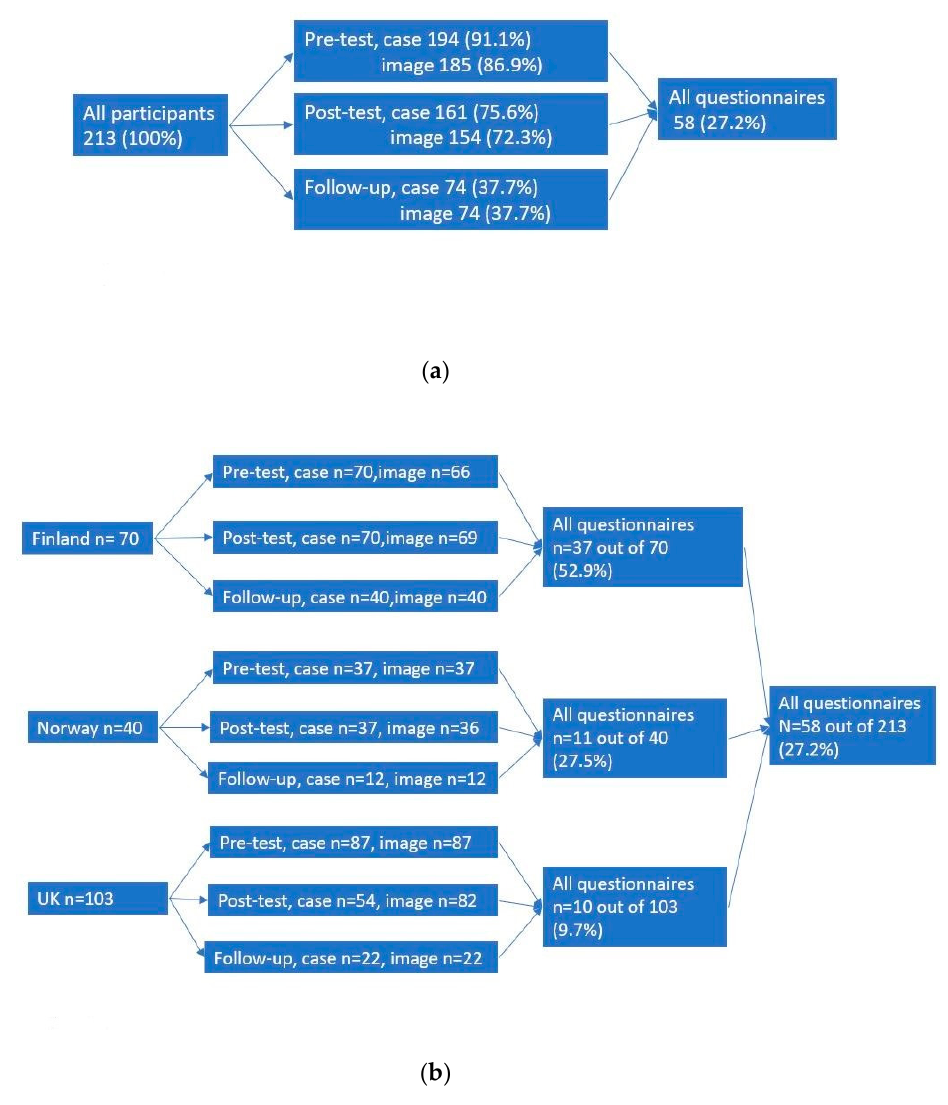
Figure 1. Returned questionnaires in pre-, post- and follow up test ( a ) and according to countries ( b ).